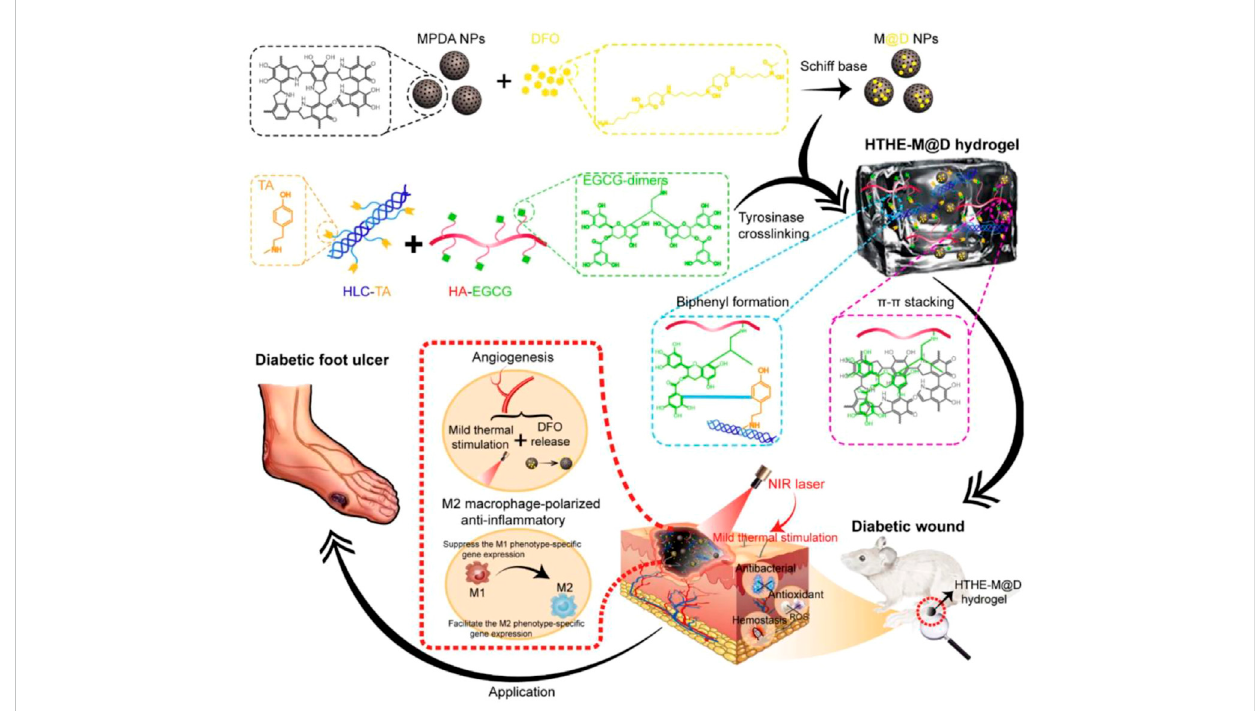
FIGURE 2 Schematic representation of the design strategy of the mussel-inspired hydrogel and mechanism of diabetic wound healing (Yuan et al.,